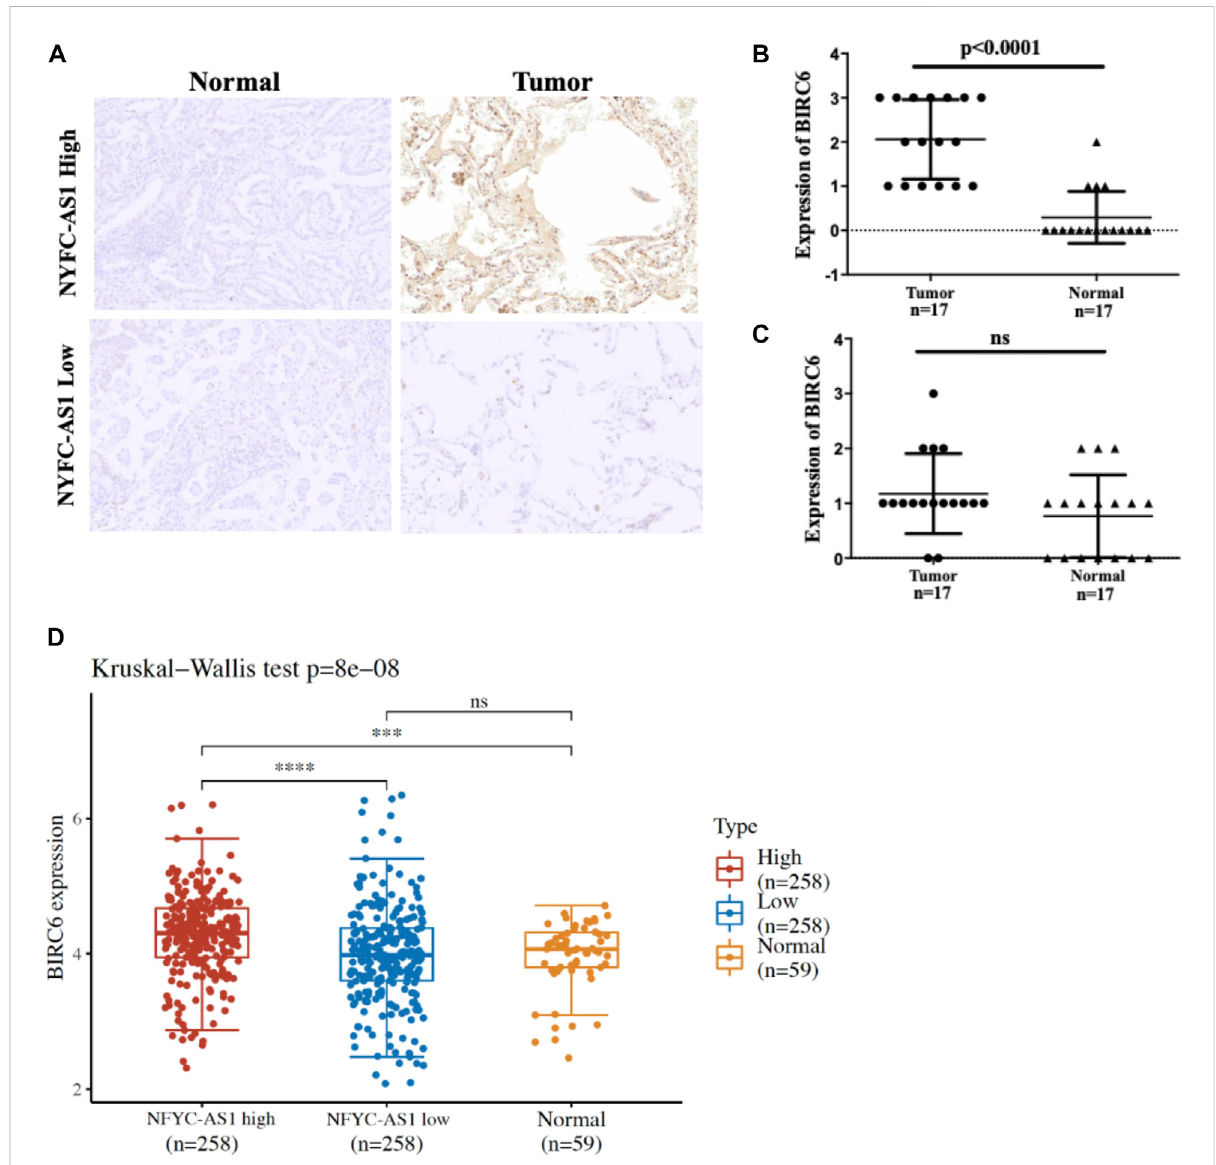
FIGURE 12 Immunohistochemistry results of 34 pair of tissues from LUAD patients. (A) Representative results of BIRC6 expression in normal and tumor tissues based on the median of NFYC-AS1 expression level. (B) The quantitative scores of above IHC results based on the higher level of NFYC-AS1 expression. (C) The quantitative scores of above IHC results based on the lower level of NFYC-AS1 expression. (D) BIRC6 expressions from TCGA database based on the median of NFYC-AS1 expression